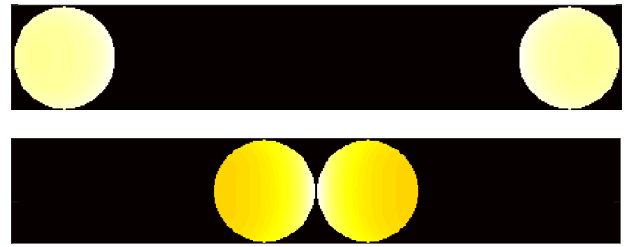
Figure 5: Normalized current distribution at 𝜁 = 1.0 .